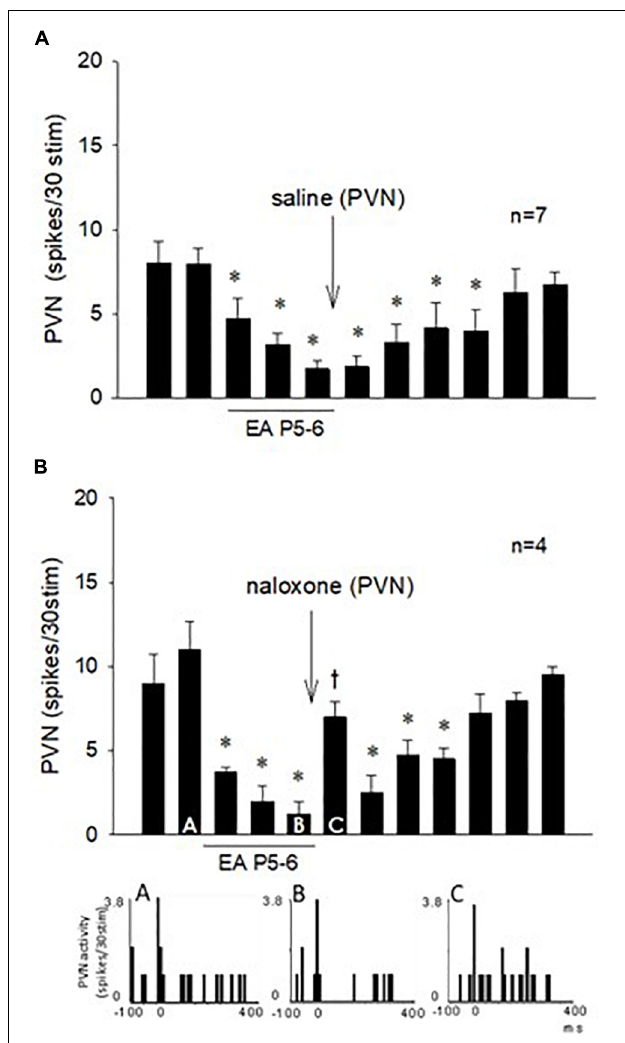
FIGURE 7 | Repeated cervical vagus nerve stimulation evoked PVN activity that was reduced by EA for at least 70 min. Saline microinjection did not influence the EA inhibition (A) . In contrast, blockade of opioid receptors in the PVN reversed the EA action (Bar C ) followed by the long-lasting EA effect for another 30 min (B) . Peristimulus histograms (A–C) display discharge activity of a cardiovascular PVN neuron with input from vagal, baroreceptor, and EA-activated median nerves. The letters A, B, and C in the peristimulus histograms correspond with the letters in the bars. ∗ Significant difference compared with control PBG response. † Significant difference from the preceding vagal-evoked activity.